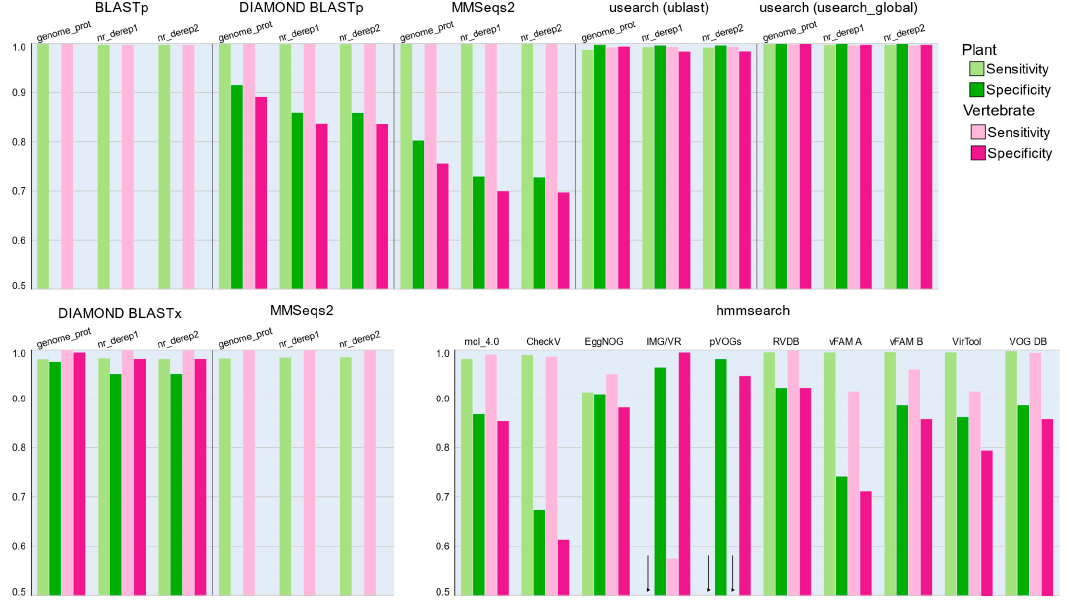
Figure 3. Sensitivity for detection of plant- and vertebrate-infecting viruses, and specificity against the plant and vertebrate sequences, using protein annotation methods. Databases used for classification are provided under each tool name. (Top) BLASTp, DIAMOND BLASTp, MMSeqs2, and usearch (ublast and usearch_global methods), after filtering for results with at least 70% identity over 50% of the query length and an e-value of less than 0.001. (Bottom, left) Nucleotide/protein